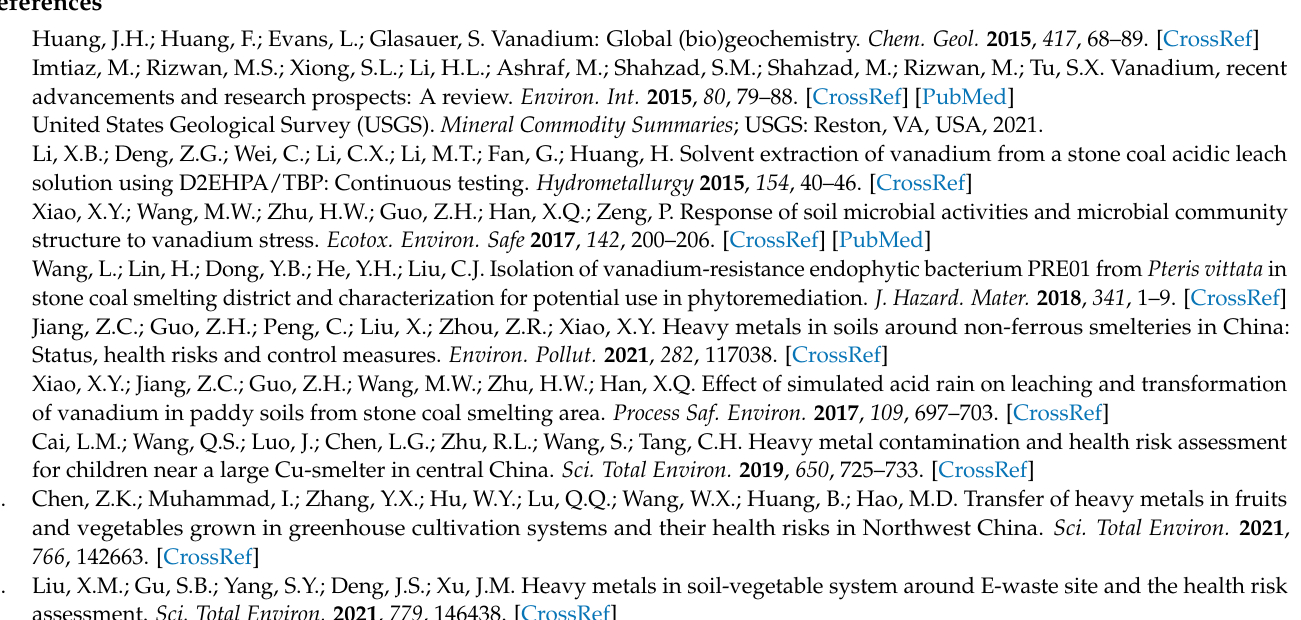
accumulation index; Table S2: Description and values of factors used in risk assessment [11,60]; Table S3: Reference dose (R f D) of trace metals [60]. Table S4: Correlation coefficient matrix of the total content of trace metals (TMs) in agricultural soils and their BAF values for